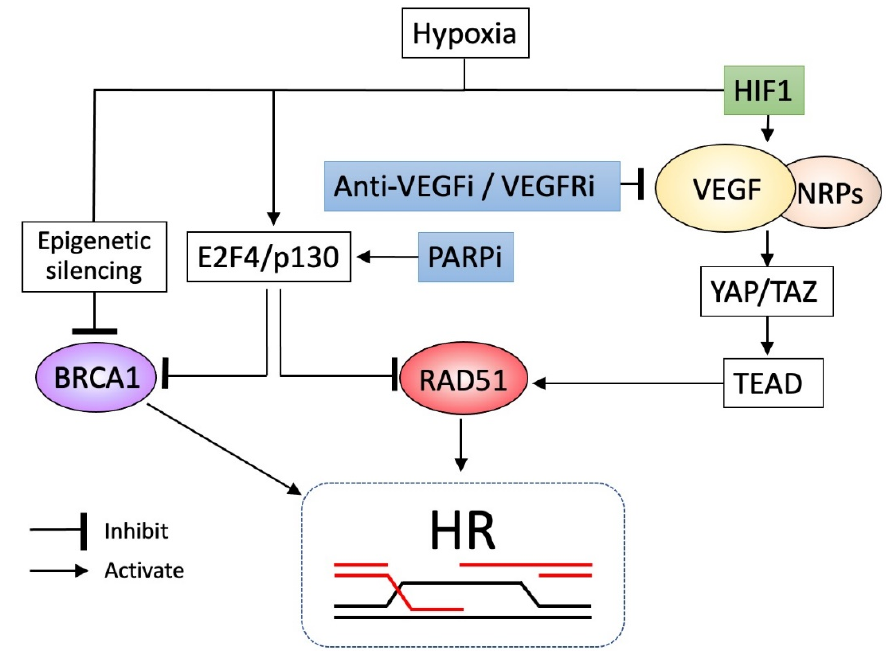
Figure 4. In this figure, PARPis and anti-VEGF/VEGFRi cooperate to induce HRD. The hypoxia- inducible factor (HIF1) increases VEGF expression, which interacts with neuropilins (NRPs), and VEGF/NRP signaling promotes homologous recombination (HR) through the Hippo pathway trans- ducers YAP/TAZ, which activate the RAD51 promoter via the transcription factor TEAD. In contrast, hypoxia inhibits RAD51 via transcriptional repressor E2F4/p130 or inhibits BRCA1 by epigenetic silencing, leading to impaired HR. Thus, hypoxia exhibits contradictory actions, inhibition, or activation of HR. In this context, anti-VEGF agents or VEGFR inhibitors (VEGFRis) suppress VEGF/NRP signaling, causing impaired HR, whereas PARPis inhibit BRCA1 and RAD51 expression via increased formation of the transcriptional repressor E2F4/p130, resulting in enhanced HRD. Thus, PARPis and anti-VEGF/VEGFRi can cooperate to elicit the HRD phenotype to achieve additive or synergistic effects.